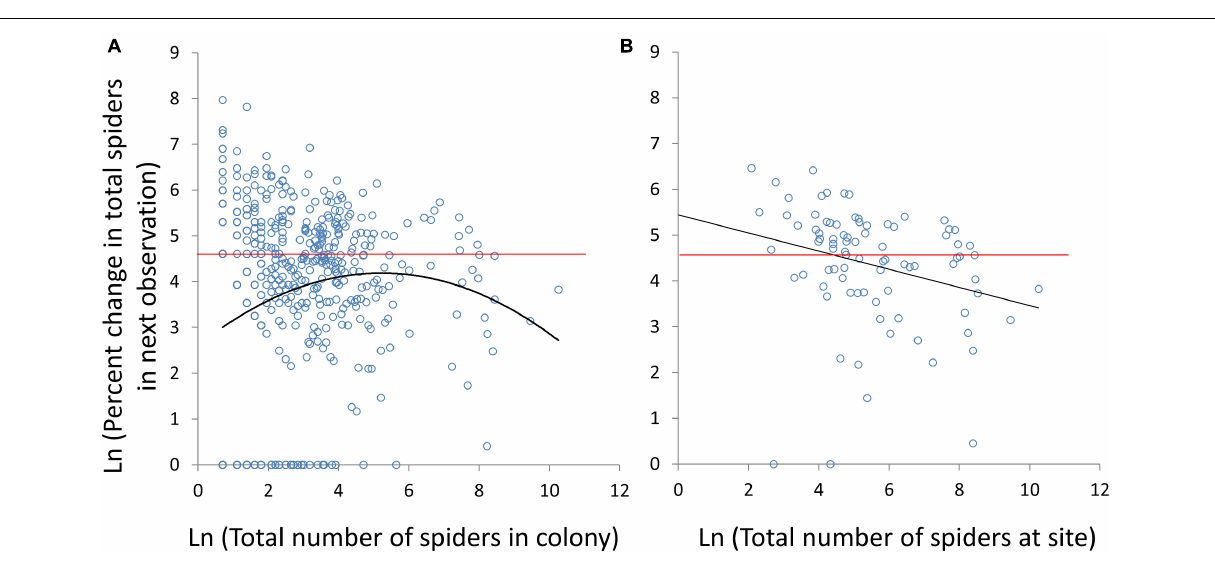
FIGURE 7 | The relationship between numbers of spiders in the colony (A) or population (i.e., at a particular site) (B) and the percent change in number in the next census. Significant quadratic and linear effects are sown in solid black lines. No change in colony or population size (Log e 100% = 4.6) is shown with a red